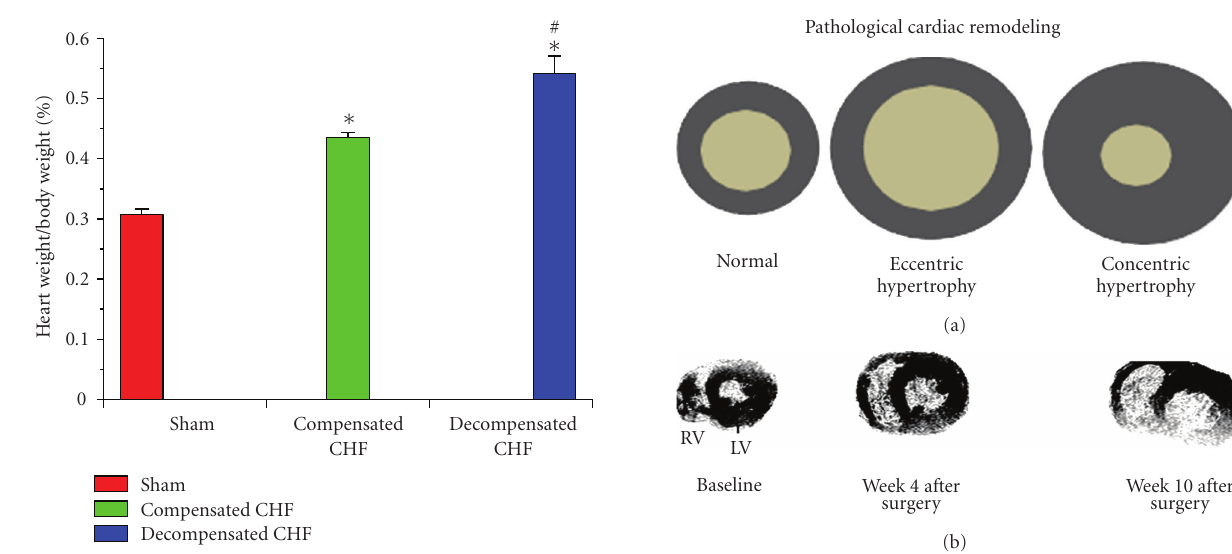
Figure 4: (a) A scheme showing pathological cardiac remodeling, eccentric versus concentric hypertrophy. (b) MRI images of hearts from sham controls and rats with aortocaval fistula at di ff erent time points. Notice that rats with AV fistula exhibited cardiac hypertrophy dilation compared with sham